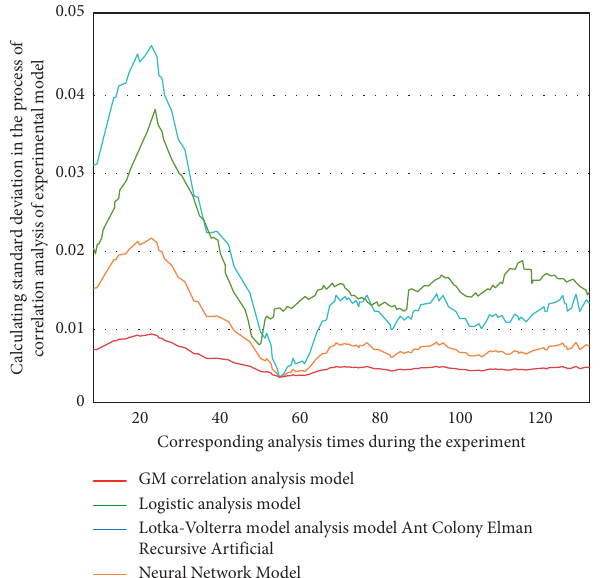
Figure 8: Correspondence calculation standard deviation under different experimental analysis